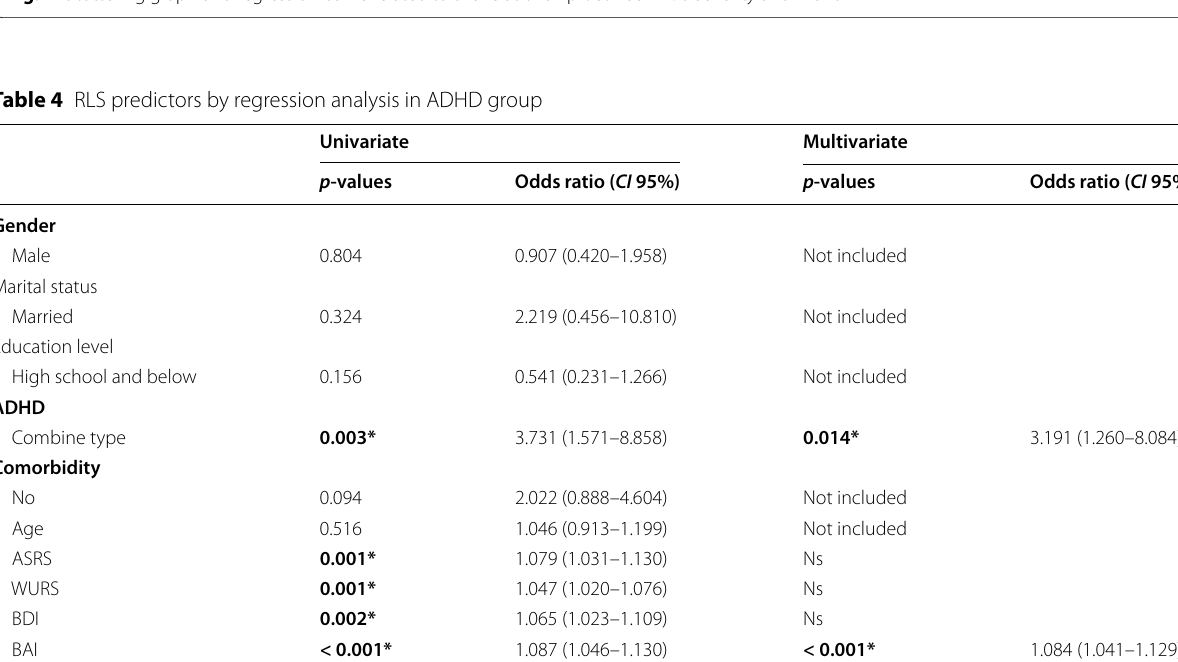
Fig. 1 Scattering graph and regression curve related to the relationship between HBS severity and WURS